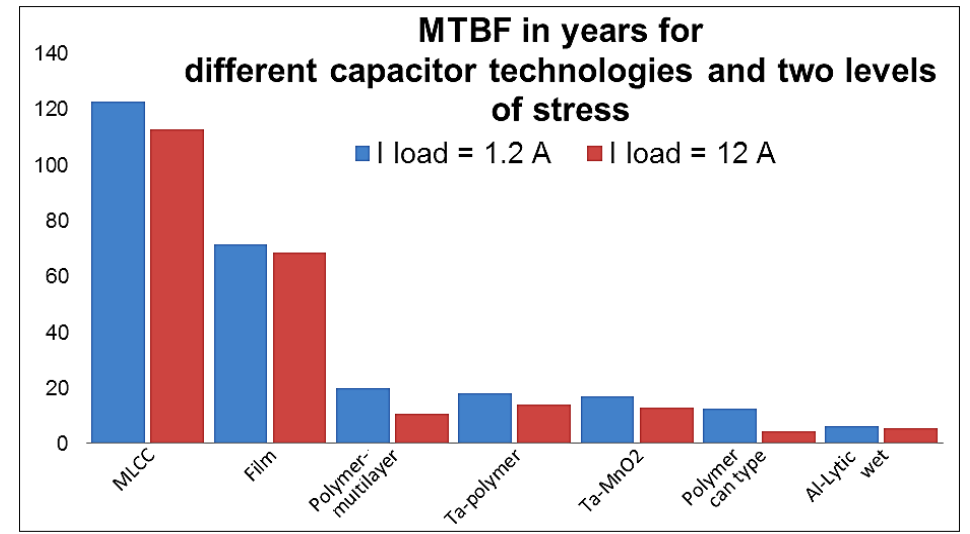
Figure 15. MTBF for seven types of capacitor technologies. Blue shows a common level of stress, and red shows a ten-fold more stressful situation.